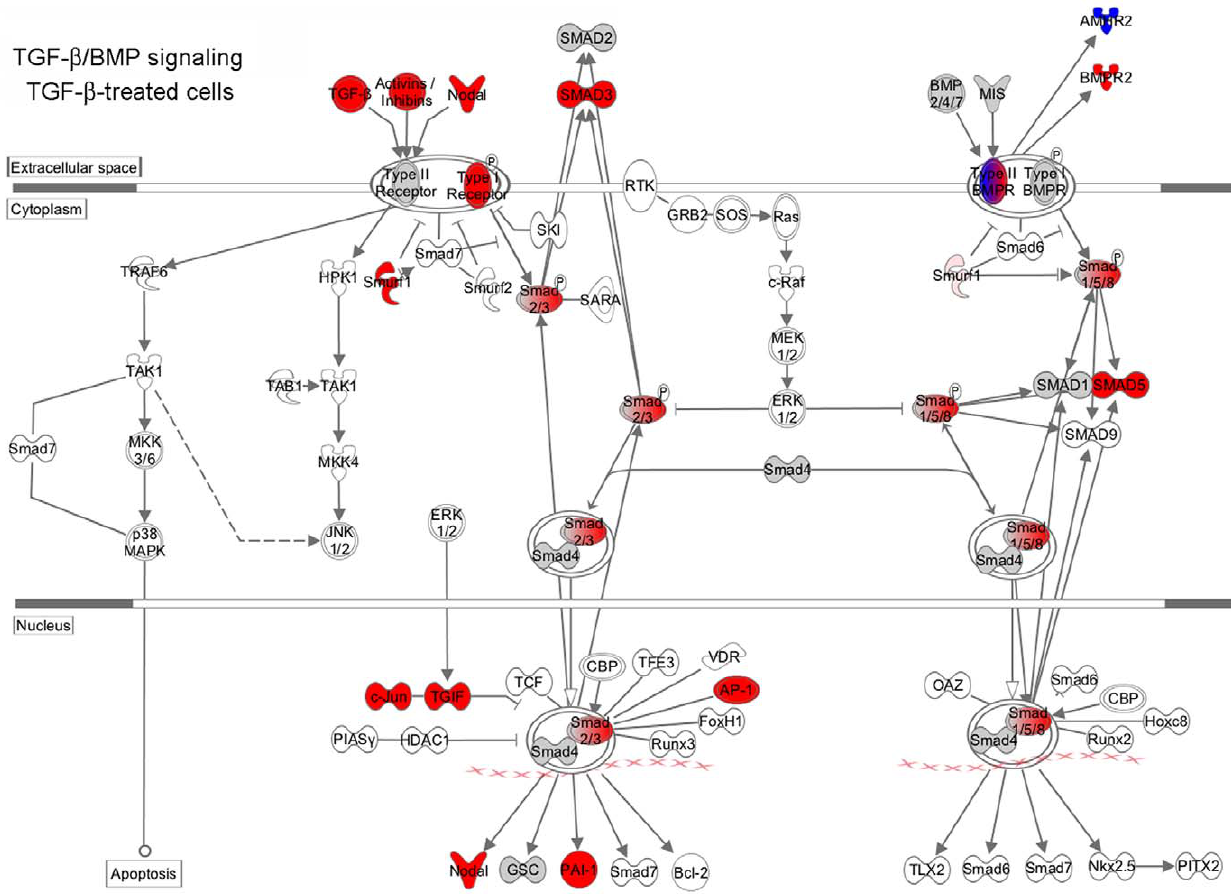
Figure 2. Mapping of changes in TGF- b /BMP signaling. Shows gene expression changes in 2.2.15 cells treated by 20 ng/ml TGF- b for 48 h versus untreated controls. Changes were mapped with curated pathways in Ingenuity Pathway Analysis. Genes with increased expression are shown in red color and genes with decreased expression are shown in blue relative to untreated control cells.